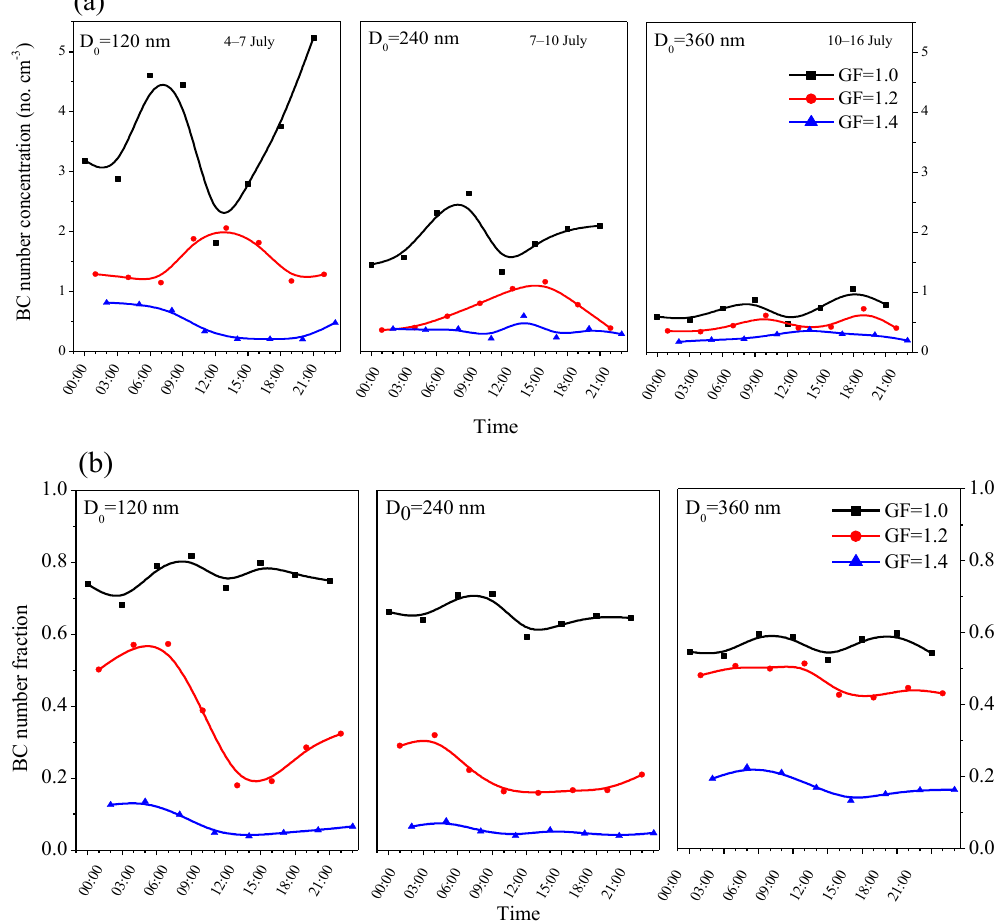
Figure 4. Diurnal variations in BC (a) number concentration and (b) number fraction (the ratio of the number concentration of BC particles to that of total particles at a certain D 0 and GF) for three selected